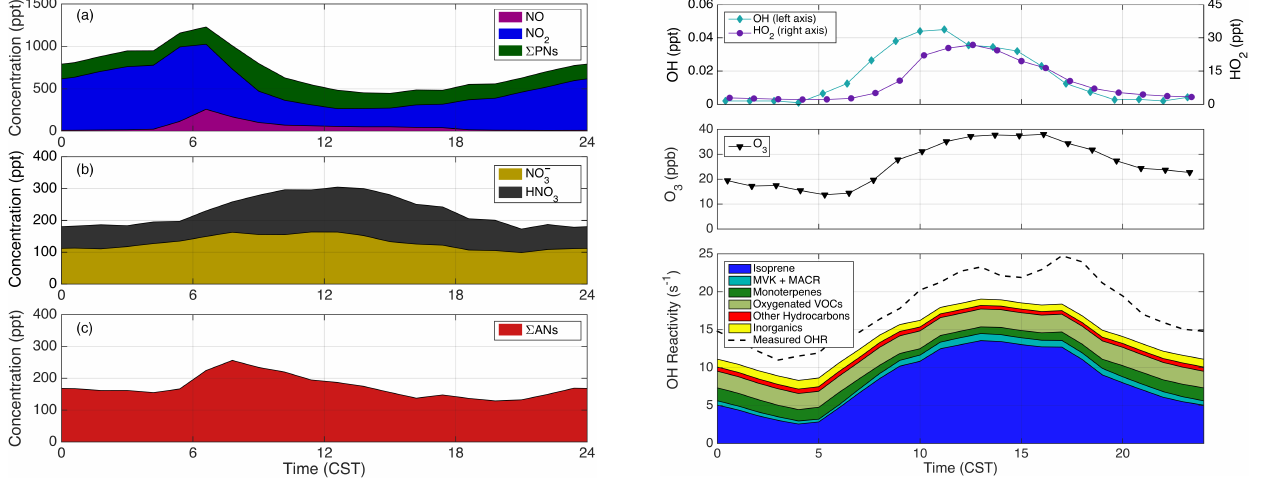
Fig. 2c. (cid:54) ANs averaged 150 ppt during the night and in- creased sharply after sunrise. After reaching a maximum of 250 ppt at 08:00, (cid:54) ANs declined slowly to a minimum con- centration of 125 ppt at sunset.